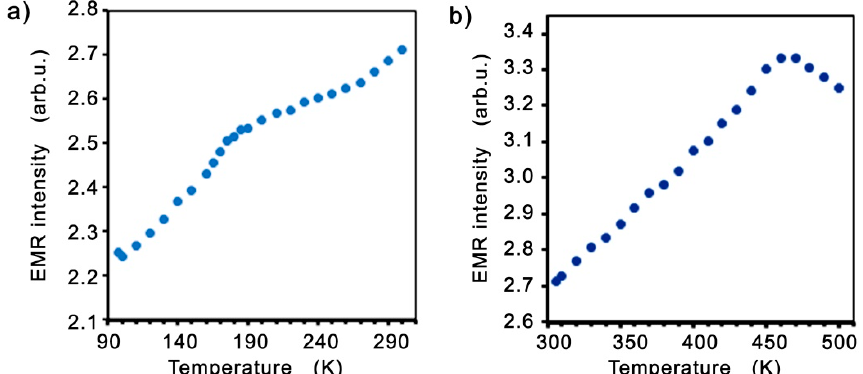
Figure 5. The EMR line intensities as a function of temperature in two temperature ranges, below ( a ), and close to T C ( b ). and close to T C ( b